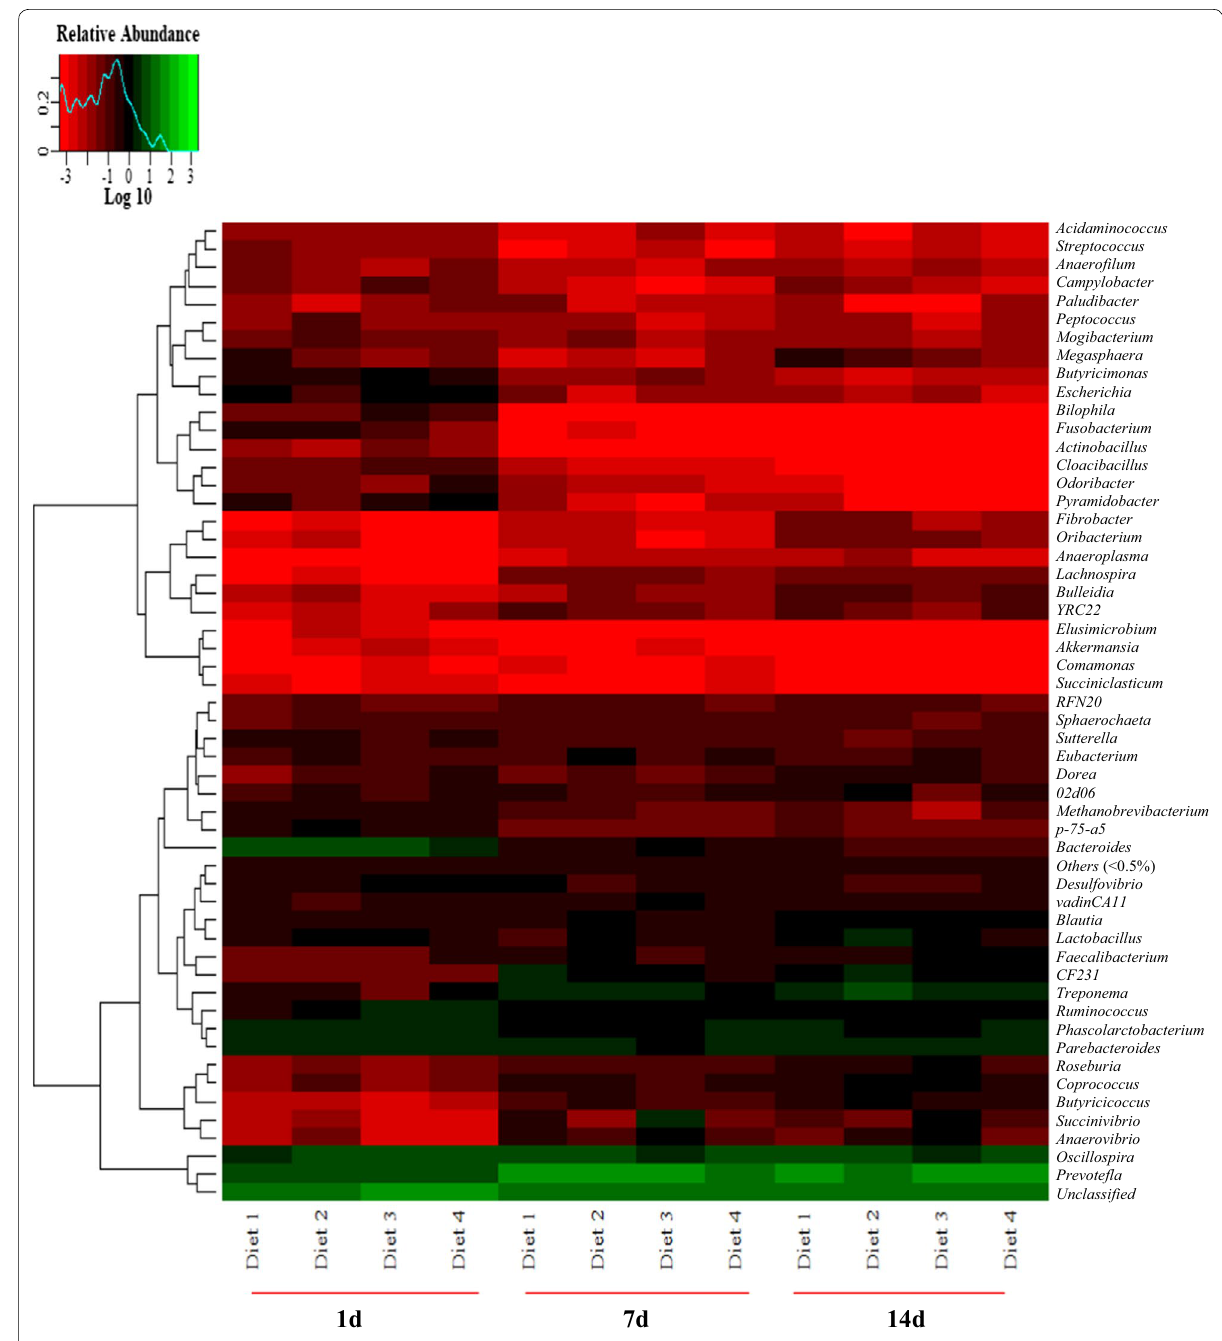
Fig. 6 Genus-level taxonomic composition of the bacterial communities of feces in weaned pigs in different phases. The feces with the highest and lowest bacterial levels are shown in green and red respectively. Bacterial genera that rank the top 50 are listed. 1 day, 7 days, and 14 days represent experimental day 1, 7, and 14,